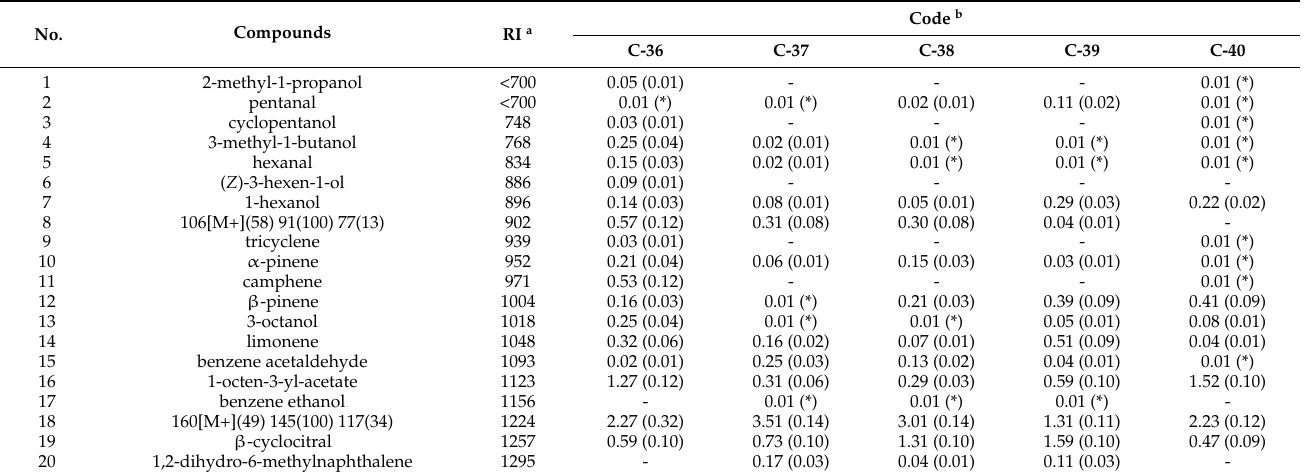
Table 9. Volatile compounds detected in the samples